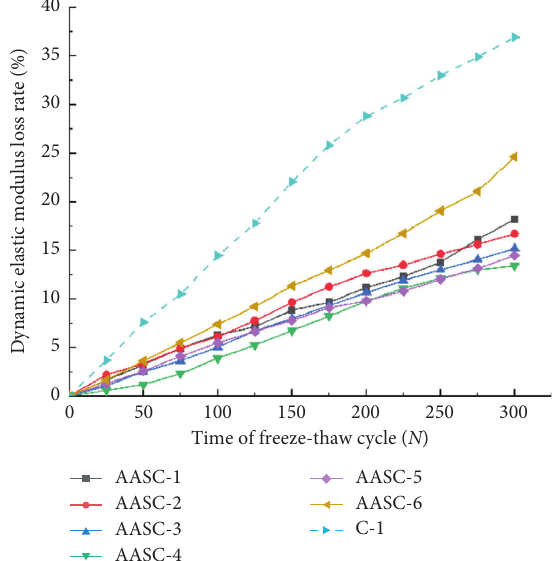
Figure 10: Relation between the dynamic elastic modulus loss rate and freeze-thaw